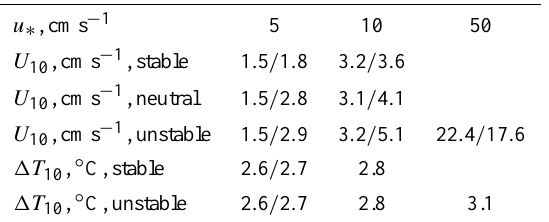
Table 1. Range of values of the wind speed and temperature differ- ence at the reference level due to changing wave